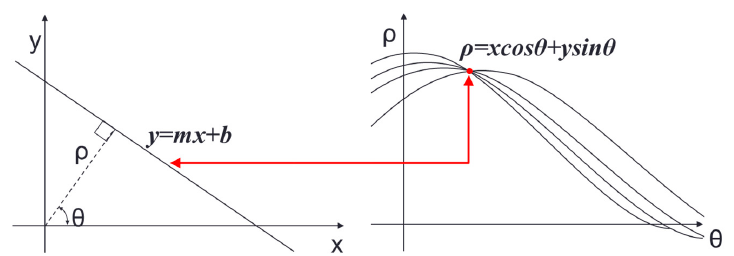
Figure 5. Principle of Hough transform.